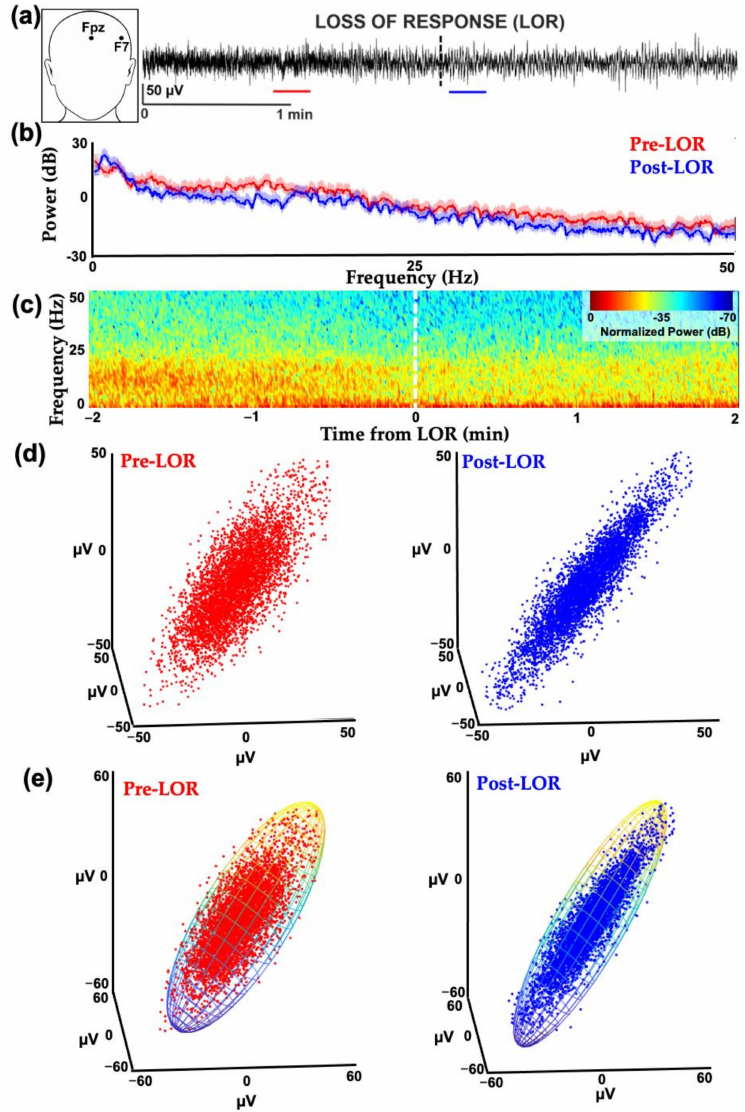
Figure 12. Example of geriatric patient EEG frontal activity from before and after loss of response with fentanyl and propofol. ( a ) EEG activity from electrode location F7 (inset) before (red line) and after (blue line) loss of response (LOR) in geriatric patient anesthetized with a combination of fentanyl and propofol. ( b ) Spectrum from 20 s EEG clip from before (red) and after (blue) LOR. ( c ) Normalized spectrogram of EEG activity starting from 2 min before LOR to 2 min following LOR. For both ( b ) and ( c ), it is difficult to see the spectral differences between before and after LOR, given the overall loss in power in the EEG signal commonly observed in geriatric patients. ( d ) Attractors from 20 s EEG clips from patients before LOR (red) to after LOR (blue). Following LOR, the same geometric shape change occurs where attractors become more ellipsoidal and flatten, as shown in previous examples. ( e ) Same attractors from ( c ), fitted with ellipsoid solid of revolution which was used for subsequent analysis. Reproduced with permission from Reference